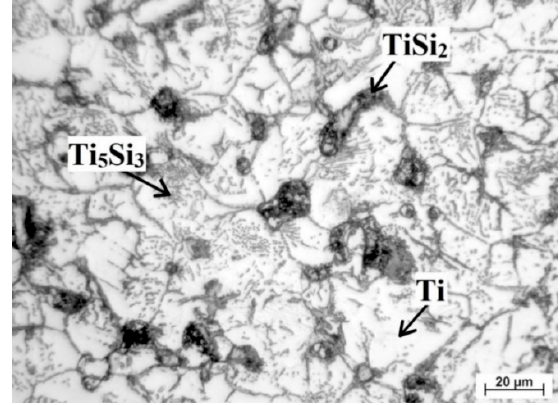
Figure 4. XRD patterns of TiSi2 and TiSi2 + 20 wt.% PA alloys. Figure 5. Detail of microstructure of TiSi2 alloy.